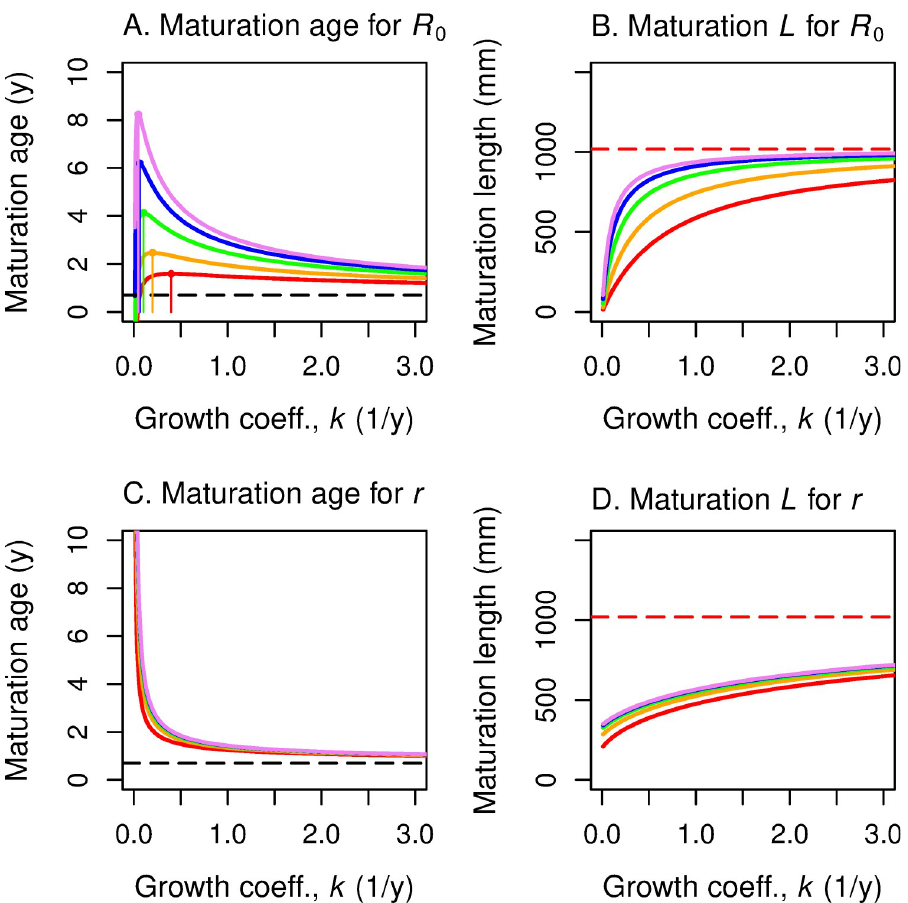
Fig 5. Optimal maturation age and length versus von Bertalanffy growth coefficient, for five survival rates. In all four panels, the horizontal axis corresponds to the growth rate k in the non-linear von Bertalanffy growth curve. The vertical axis presents the optimal maturation age on the left two panels (A, C) and the optimal maturation length on the right two panels (B, D), for each value of k . For the top two panels the underlying fitness function is R 0 ; for the bottom two panels the underlying fitness function is r . In each panel, optimal age and size curves are drawn for five values of survival rates s (red: 0.25; orange: 0.50; green: 0.70; blue: 0.80; violet: 0.85). As the annual survival rate increases from s = 0.25 to 0.85, the optimal maturation age and length increase for a given k . In panels A & C, the horizontal black dashed line indicates the age at smolting; the colored points at the peak of the vertical lines indicate the maximum value of optimal maturation ages for a given annual survival s . In panels B and D, the horizontal red dashed line represents the asymptotic length of the von Bertalanffy growth function.